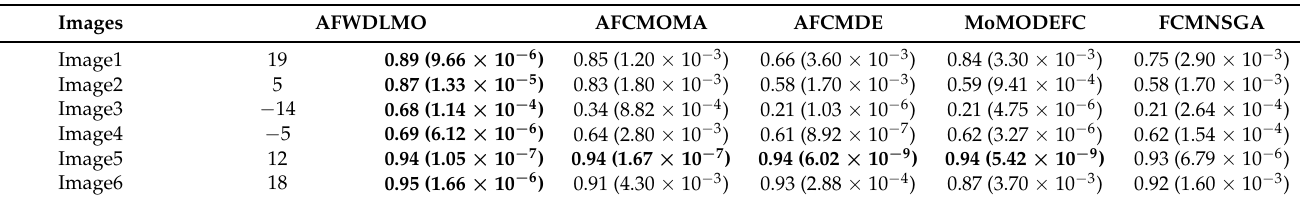
Table 1. Mean and variance of ARI on texture